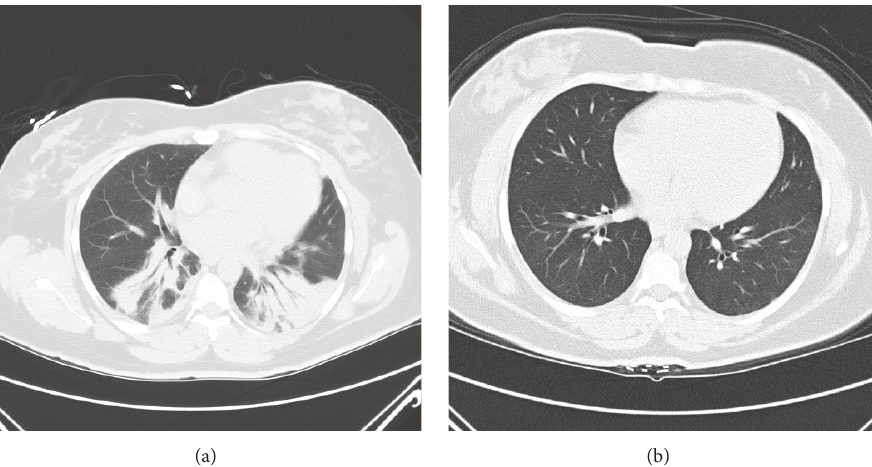
Figure 1: Computed tomography (CT) scans of case subject lungs prior to (a) and after (b) discontinuation of hydralazine therapy.